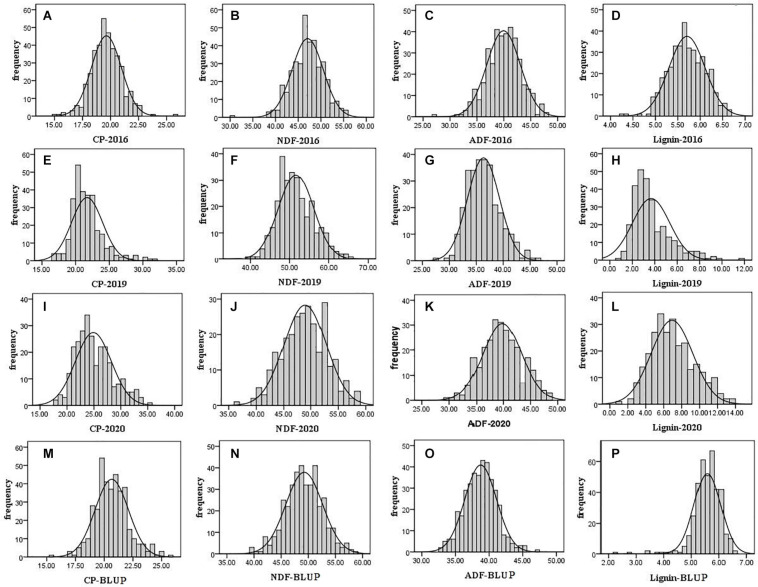
Frequency distribution histogram of F1 population quality traits in 2016, 2019, and 2020. The black solid line is the normal distribution curve. The traits are include the following: (A) CP in 2016; (B) NDF in 2016; (C) ADF in 2016; (D) lignin in 2016; (E) CP in 2019; (F) NDF in 2019; (G) ADF in 2019; (H) lignin in 2019; (I) CP in 2020; (J) NDF in 2020; (K) ADF in 2020; (L) lignin in 2020; (M) CP of BLUP; (N) NDF of BLUP; (O) ADF of BLUP; and (P) lignin of BLUP.